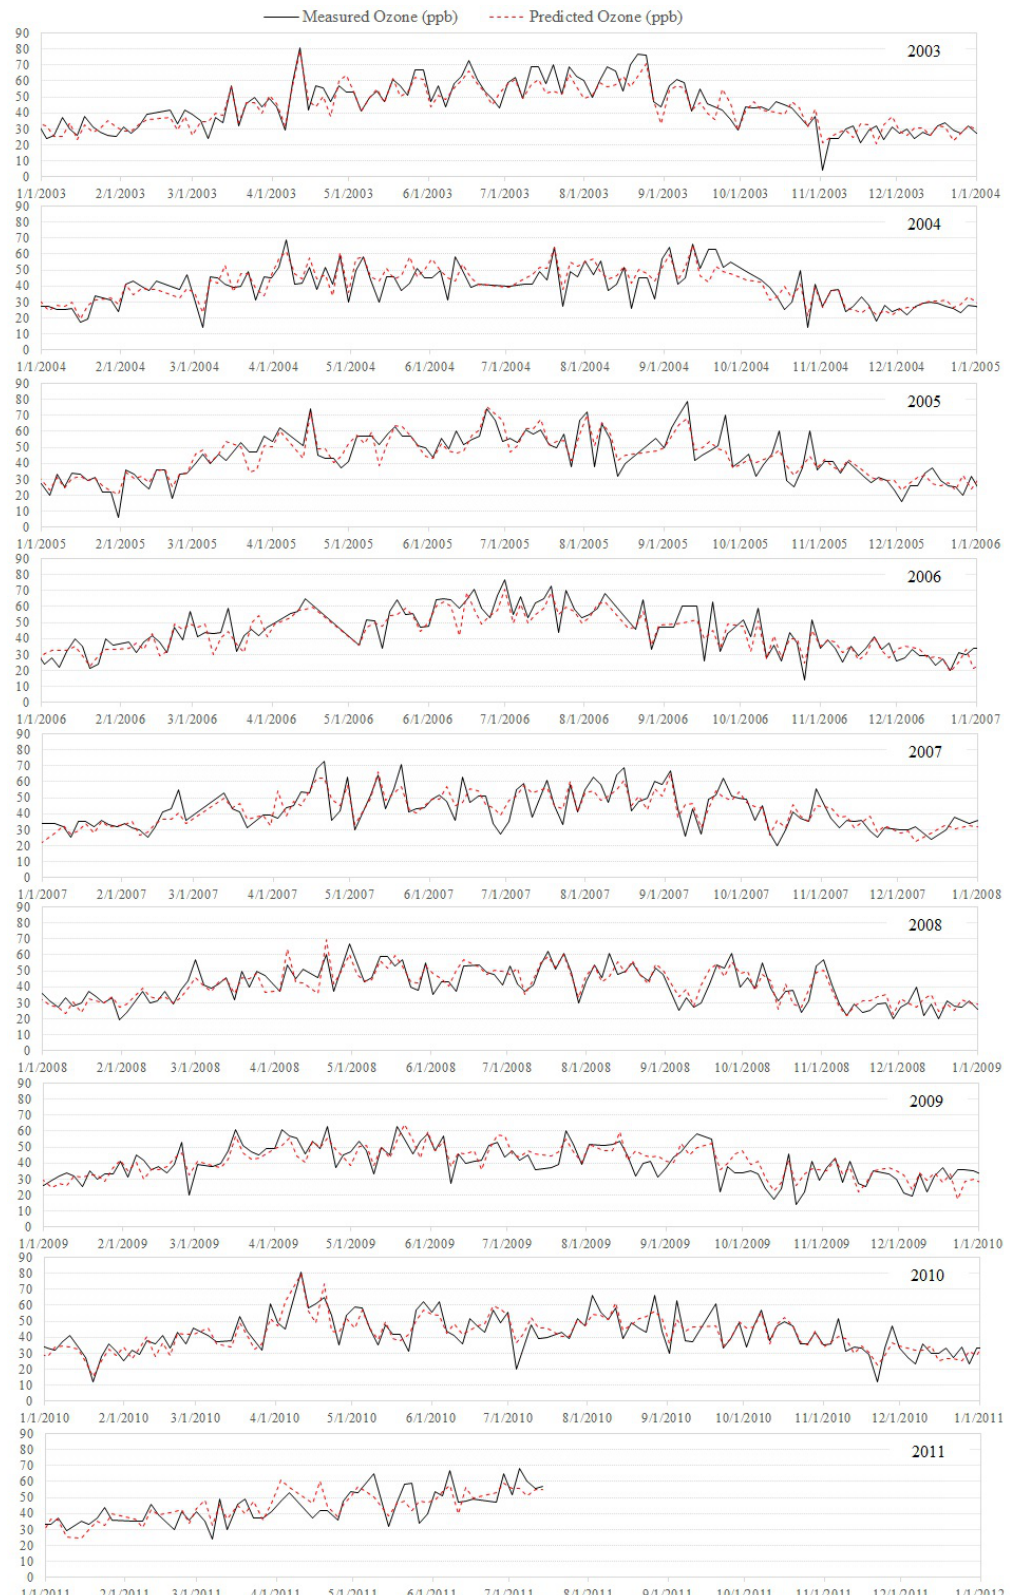
Figure 4. Measured and predicted ozone levels at the Konza Prairie site (2003–2011).